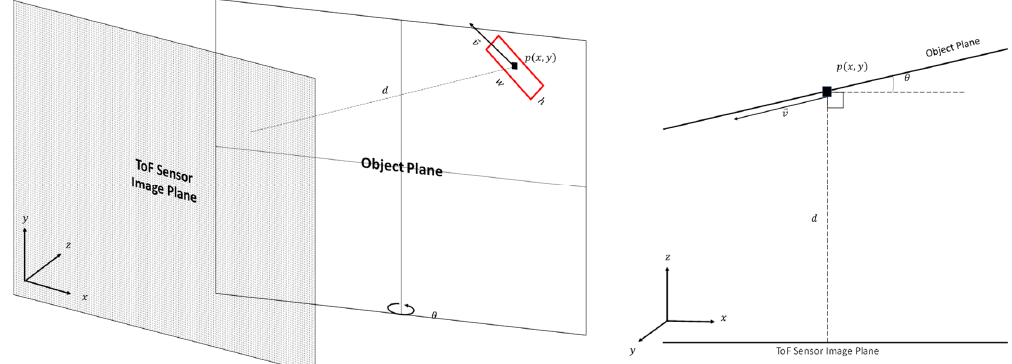
Figure 2. Perspective view of a relationship of between a ToF sensor image plane and motion of an object in an object plane. For simplicity, the object's movement is along a single plane ( left ). Top view of the relationship between the ToF sensor image plane and the movement of the object in the object plane ( right ).